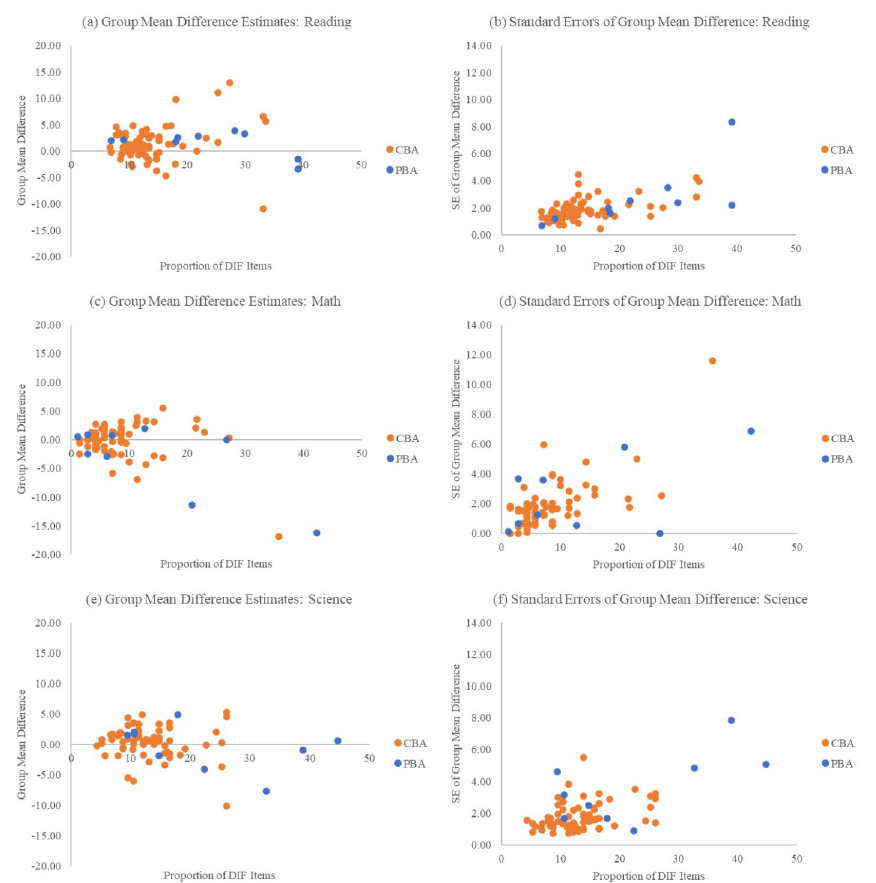
Fig. 2 PISA 2018 cognitive domain country score differences with and without DIF adjustment and their standard error estimates across the proportion of DIF